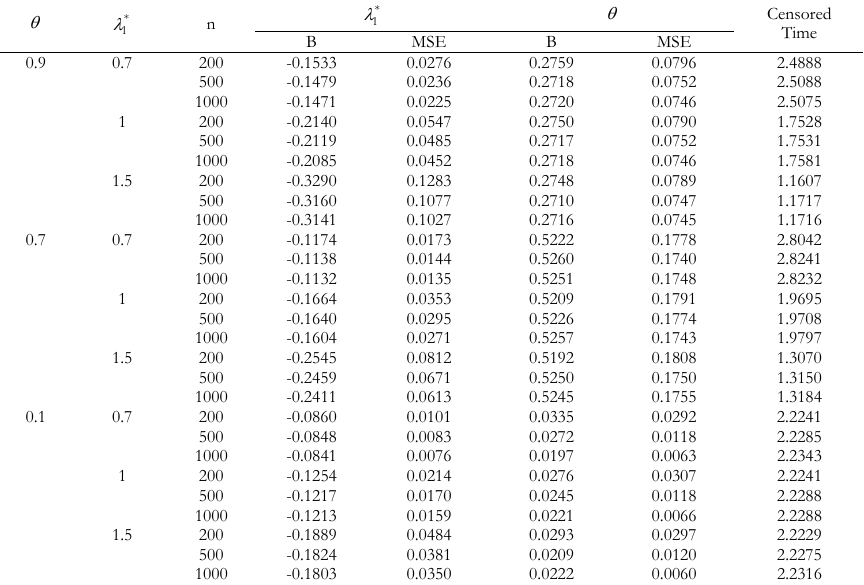
Exponential distribution: censored